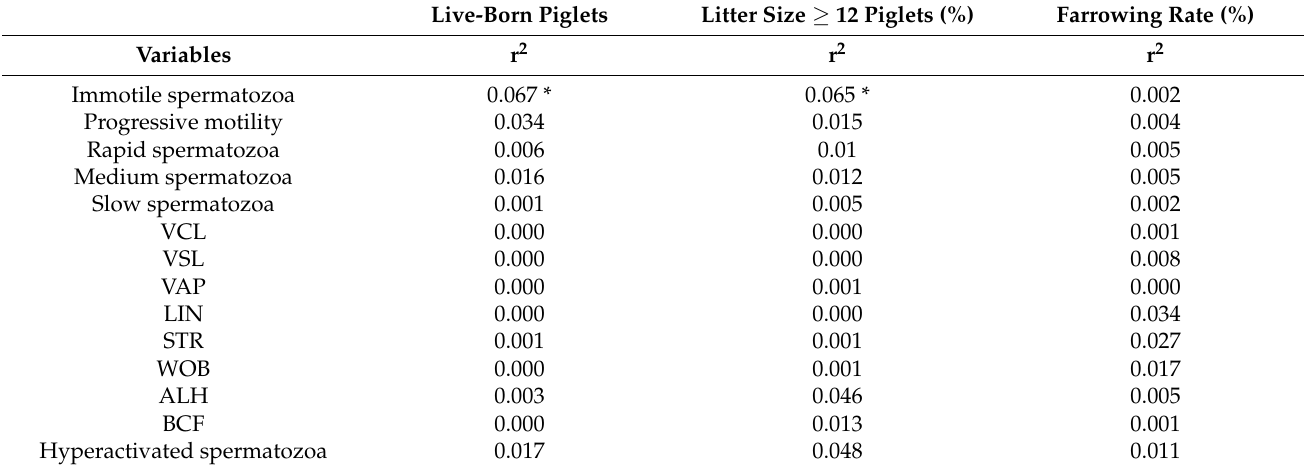
Table 4. Effect of boar sperm kinetics on reproductive outcomes.